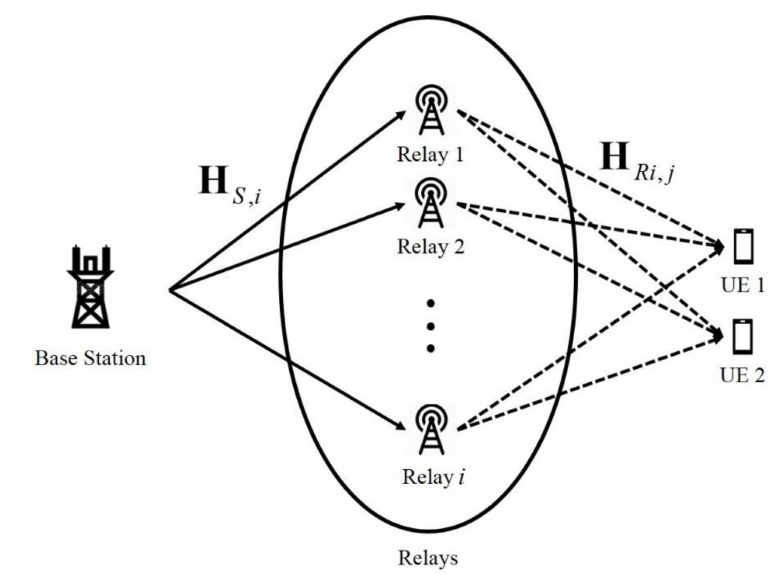
Figure 1. The system model for proposed relay selection